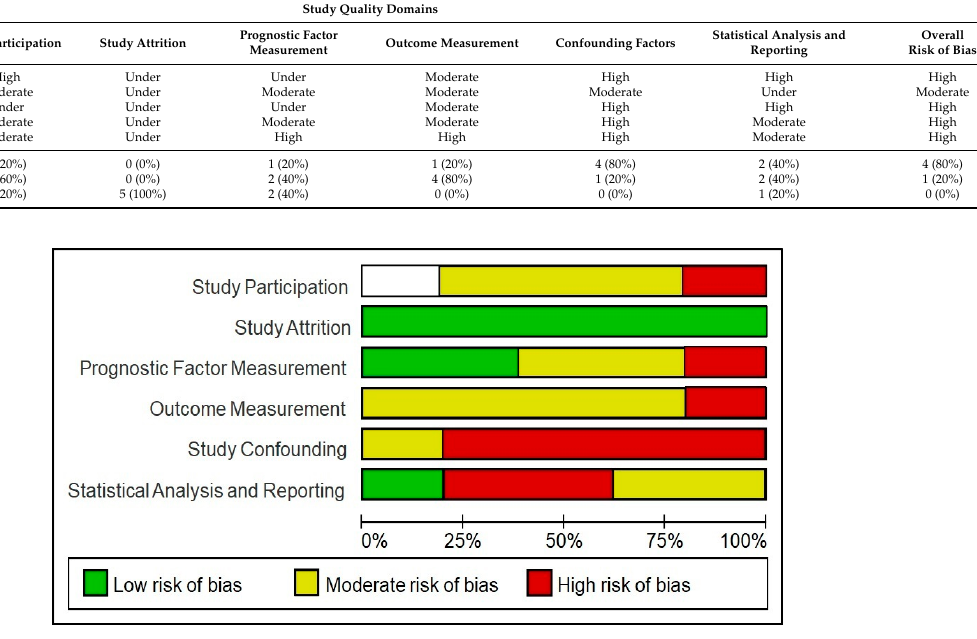
Figure 5. Risk of bias of included studies using the QUIPS tool. This graph shows the different items assessed in the QUIPS tool and the percentage of studies with a high, moderate or low risk of bias.